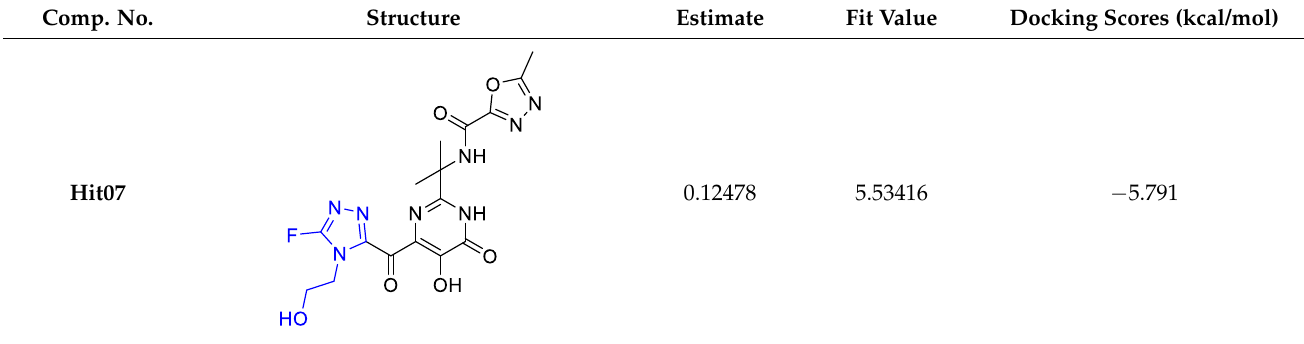
Figure 7. The pathway to elicit compounds ( Hit07 – Hit12 ) from template molecule ( Hit01 ) using side-chain hopping. Table 7. Structures of selected candidate compounds ( Hit07 – Hit09 and Hit10 – Hit12 ) with Estimate activity, Fit value and docking scores.